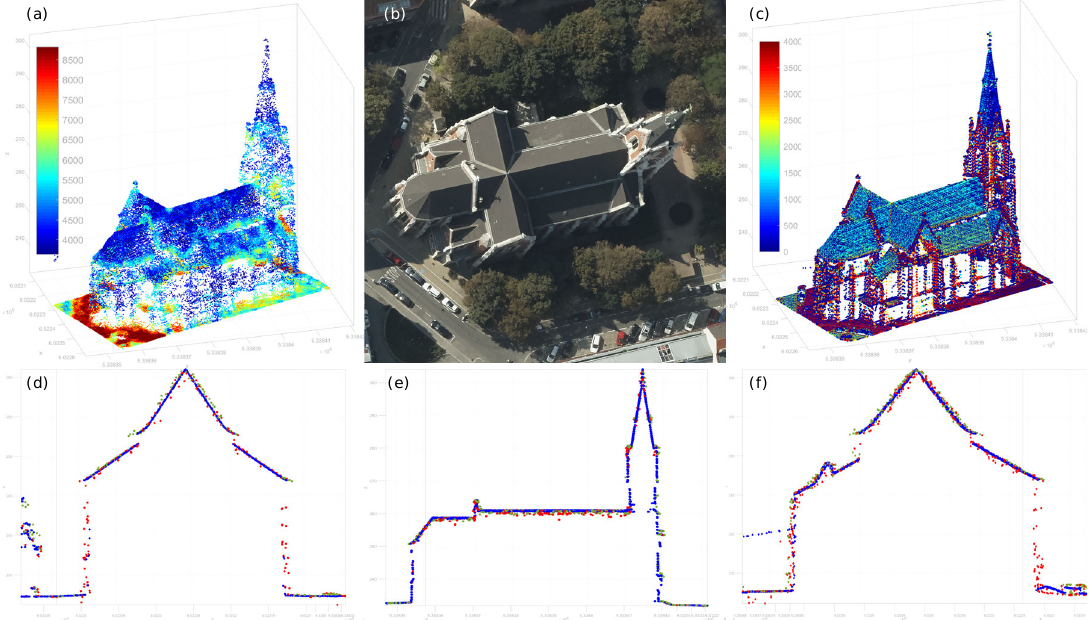
Figure 5. 3D point cloud of the church (city test area) after clutter point removal; (a) perspective view of SPL point cloud colored by intensity [DN], (b) aerial image (PhaseOne, September 2018), (c) perspective view of waveform LiDAR point cloud colored by signal amplitude [DN], (d-f) section views (cross, longitudinal, diagonal): SPL unfiltered/postprocessed (red/green), waveform LiDAR